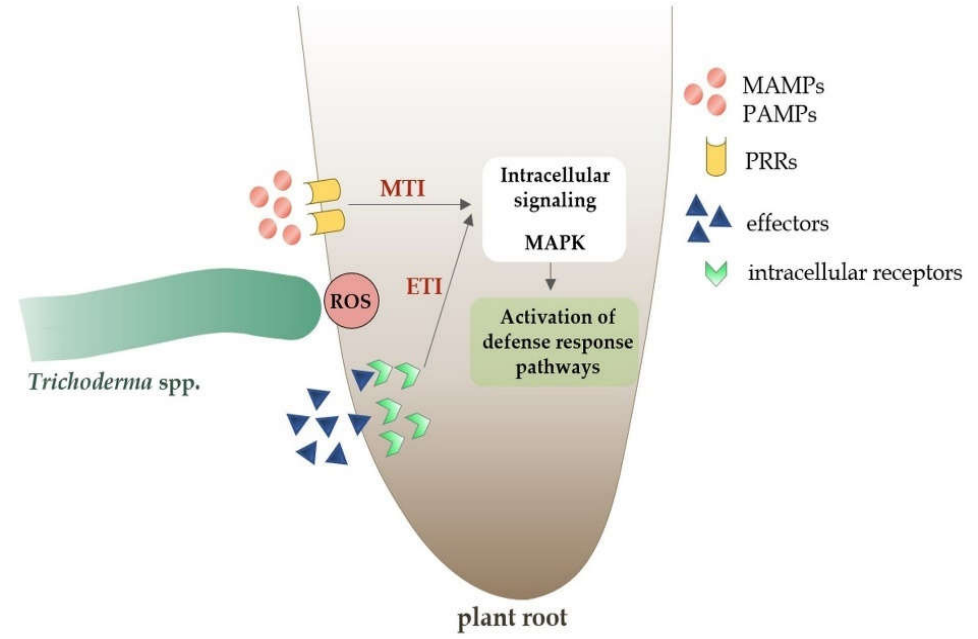
Figure 5. Plant defense response pathways to microbe-associated molecular pattern (MAMPs) molecules and effectors from non-pathogenic Trichoderma spp.